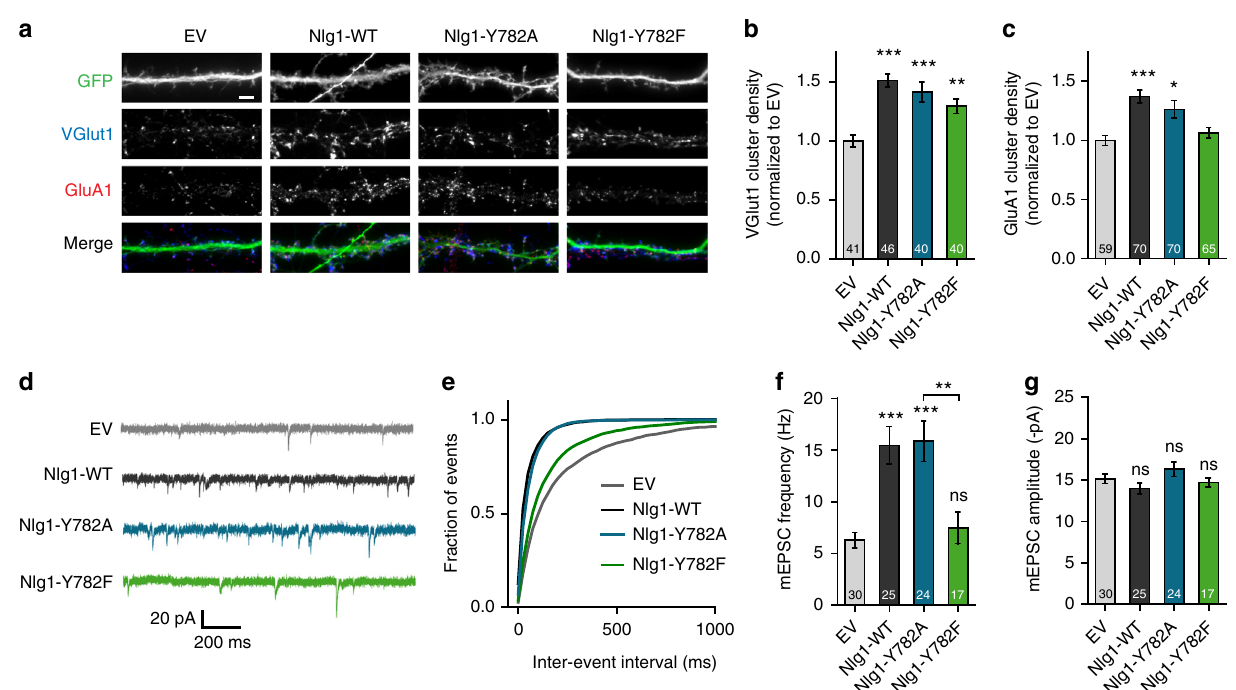
Fig. 2 Effects of Nlg1 mutants on excitatory synapse differentiation. a Dendrites from DIV 14 – 15 cultured neurons co-transfected with GFP (green) and either EV, Nlg1-WT, -Y782A, or -Y782F. Neurons were live stained with an N-terminal GluA1 antibody (red) and counterstained with a VGlut1 antibody (blue). Scale bar, 5 µ m. b , c Density of VGlut1 or GluA1 clusters, respectively, normalized to the EV condition (number of cells indicated within the bars, from 3 independent experiments). d Representative traces of mEPSCs recordings from DIV 14 – 15 neurons expressing EV, Nlg1-WT, -Y782A, or -Y782F clamped at − 70 mV in the presence of TTX and bicuculline. e Cumulative distributions of the mEPSCs inter-event intervals for the corresponding conditions. f , g Mean mEPSC frequencies and amplitudes, respectively, for each condition (number of cells indicated within the bars, from 3 independent experiments). Data in graphs b , c , f , and g represent mean ± SEM and were compared by a Kruskal – Wallis test followed by Dunn ’ s multiple comparison test (ns: not signi fi cant, * P < 0.05, ** P < 0.01, *** P <